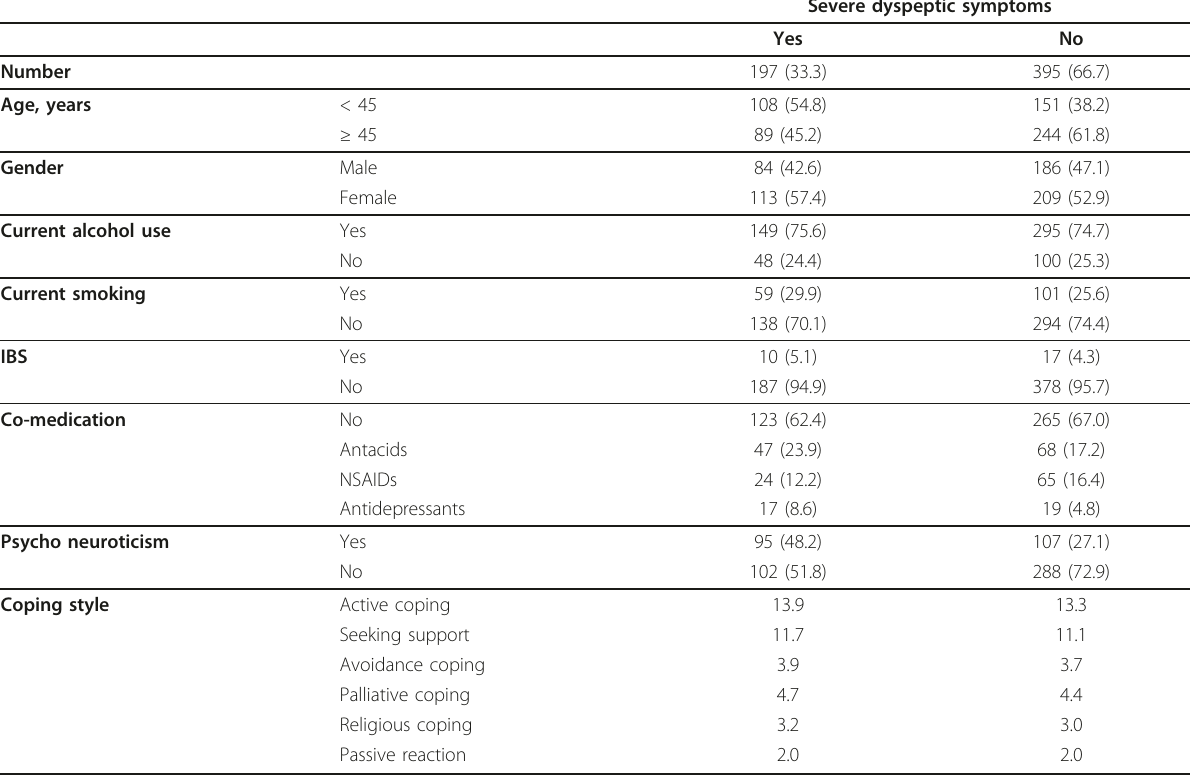
Table 2 Patients characteristics according to dyspeptic symptom severity